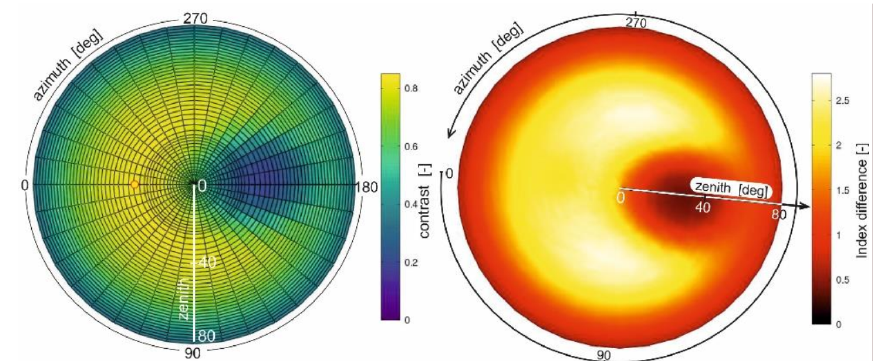
Figure 4. Compilation of the contrast distribution (left, after being extracted from [2]) and the difference in the spectral index (right, extracted from Figure 3) depending on the viewing angle. The thickness of the oily layer is 5 m and the sea surface is wavy due to a wind speed of 5